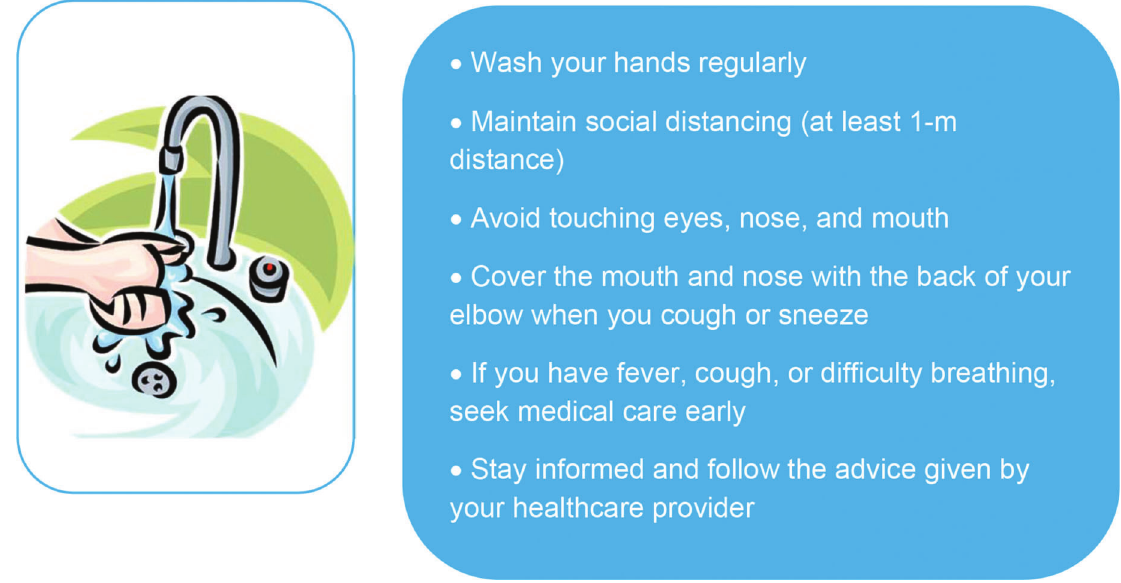
Figure 1 - General measures and precautions to be taken during the COVID-19 pandemic in pediatric IBD. Modified from Danese et al. (25) and Turner et al. (26).